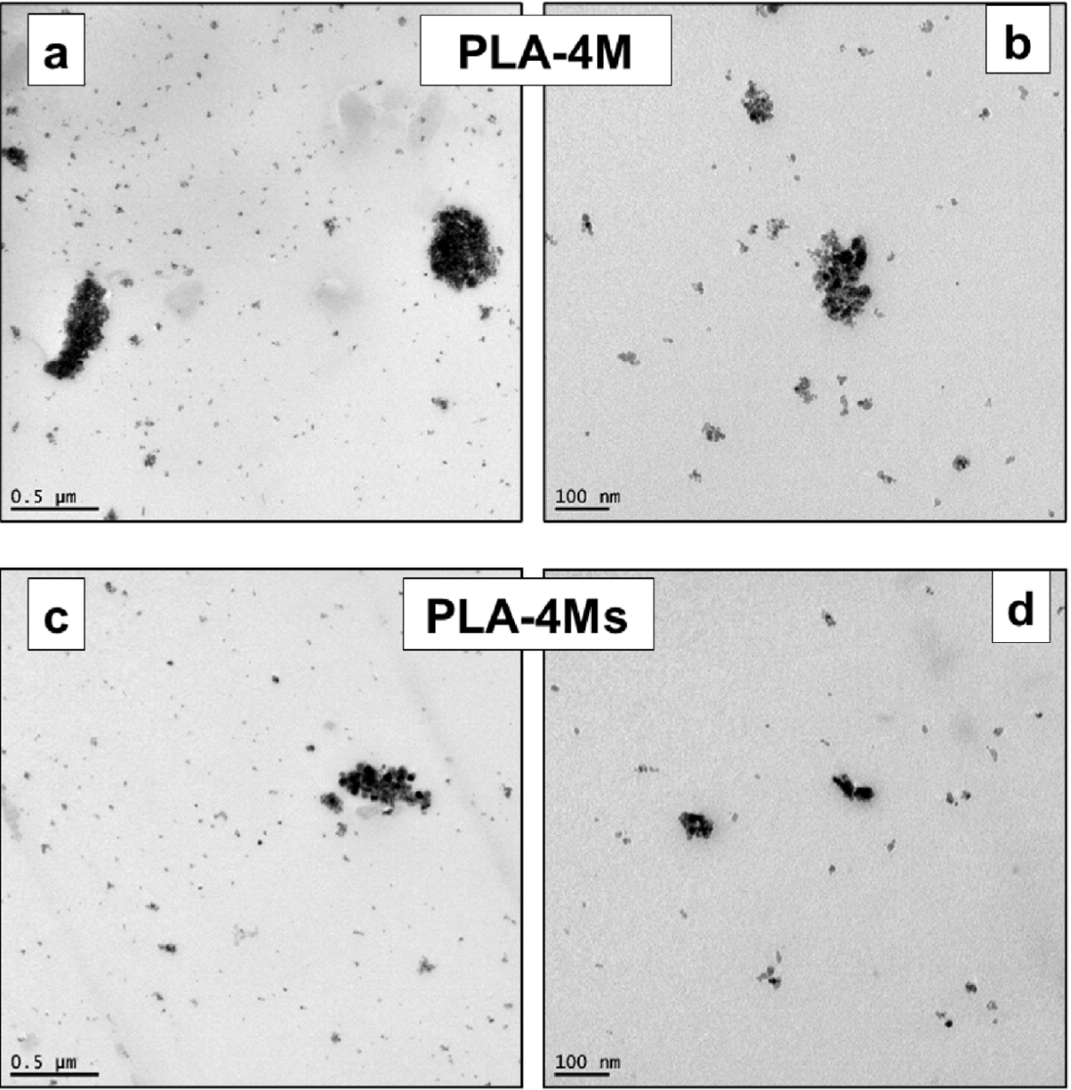
Figure 12. ( a – c ) TEM pictures at different magnifications of PLA–4% magnetite nanocomposites produced using untreated ( a , b ) and surface treated MNPs ( c , d ).